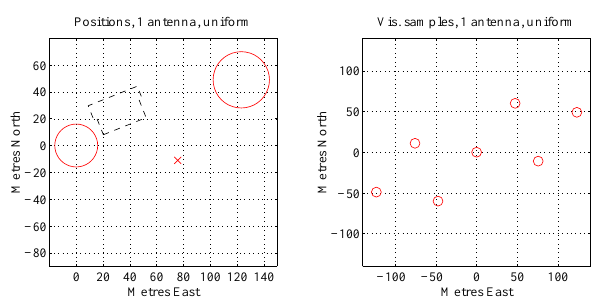
Fig. 2. The left panel shows the antenna configuration which will be used for the first passive receiving antenna, indicated by a cross. The antenna is placed in the centre of an equilateral triangle where the larger antennas, marked by circles of the diameter of each dish, form two of the three vertices. The position and orientation of the ESR building is indicated by the dashed outline. The panel to the right shows which points of the visibility function are sampled by this setup. As there are no short baselines in this configuration, the problems with aliasing rules out imaging, as the examples in Fig. 3 show. Even so, it will verify that it is possible to detect the signal in such an antenna, and that it is possible to estimate correlations between the signals in the large and the small